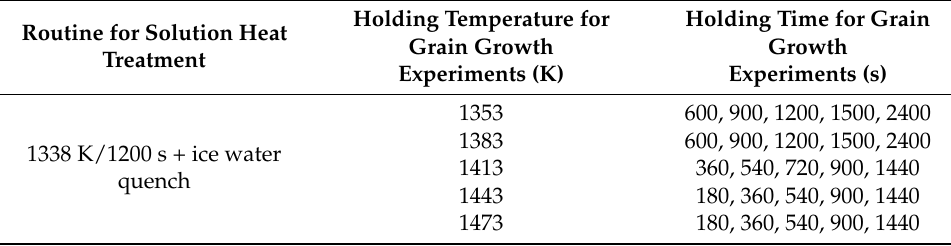
Table 2. Experimental procedure of grain growth tests. Routine for Solution Heat Treatment